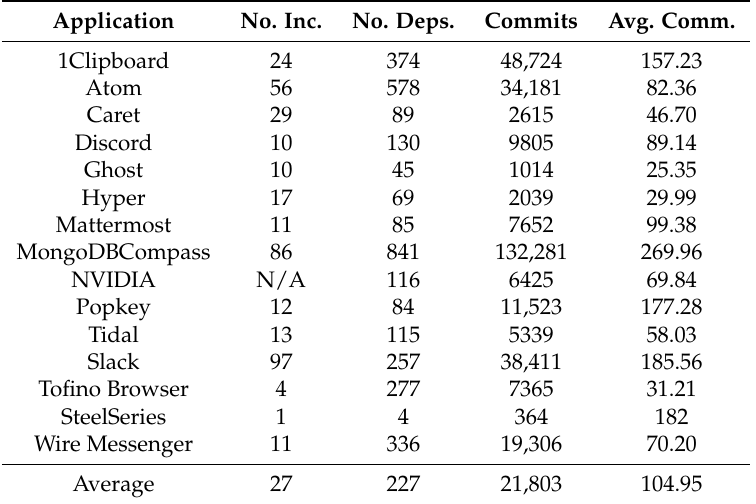
Table 2. An automated scan of fifteen popular Electron